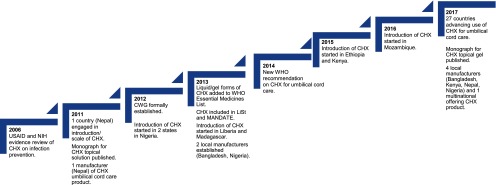
Timeline of Key Milestones Related to the Chlorhexidine Working Group, 2006–2017Abbreviations: CHX, chlorhexidine; CWG, Chlorhexidine Working Group; LiST, Lives Saved Tool; MANDATE, Maternal and Neonatal Directed Assessment of Technologies; NIH, National Institutes of Health; USAID, United States Agency for International Development; WHO, World Health Organization.